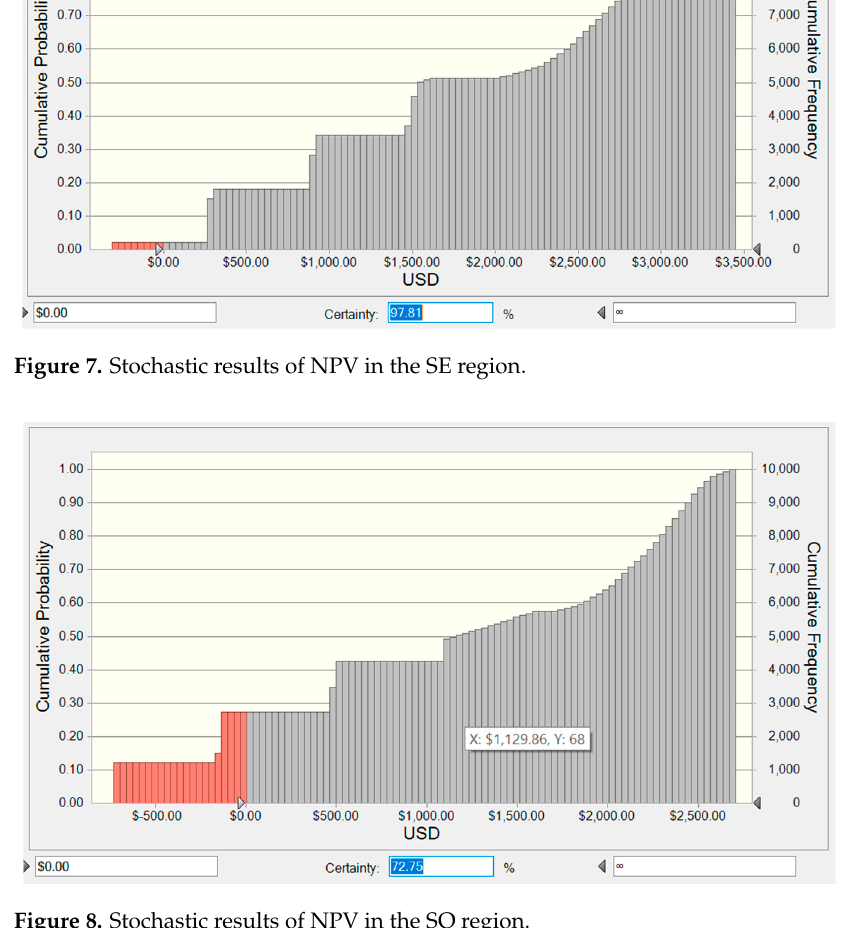
10 of 14 Figure 5. Stochastic results of NPV in the NE region.